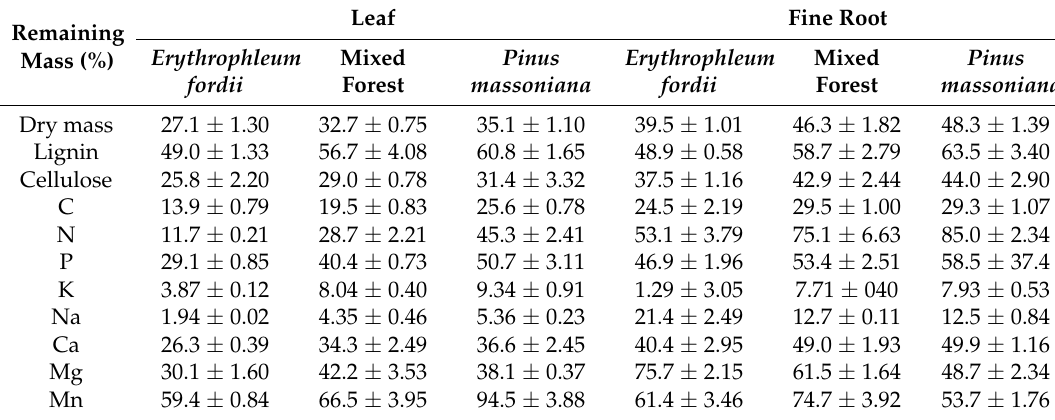
Table 3. Remaining mass of dry mass, organic chemical components, and nutrient elements at the end of the decomposition.